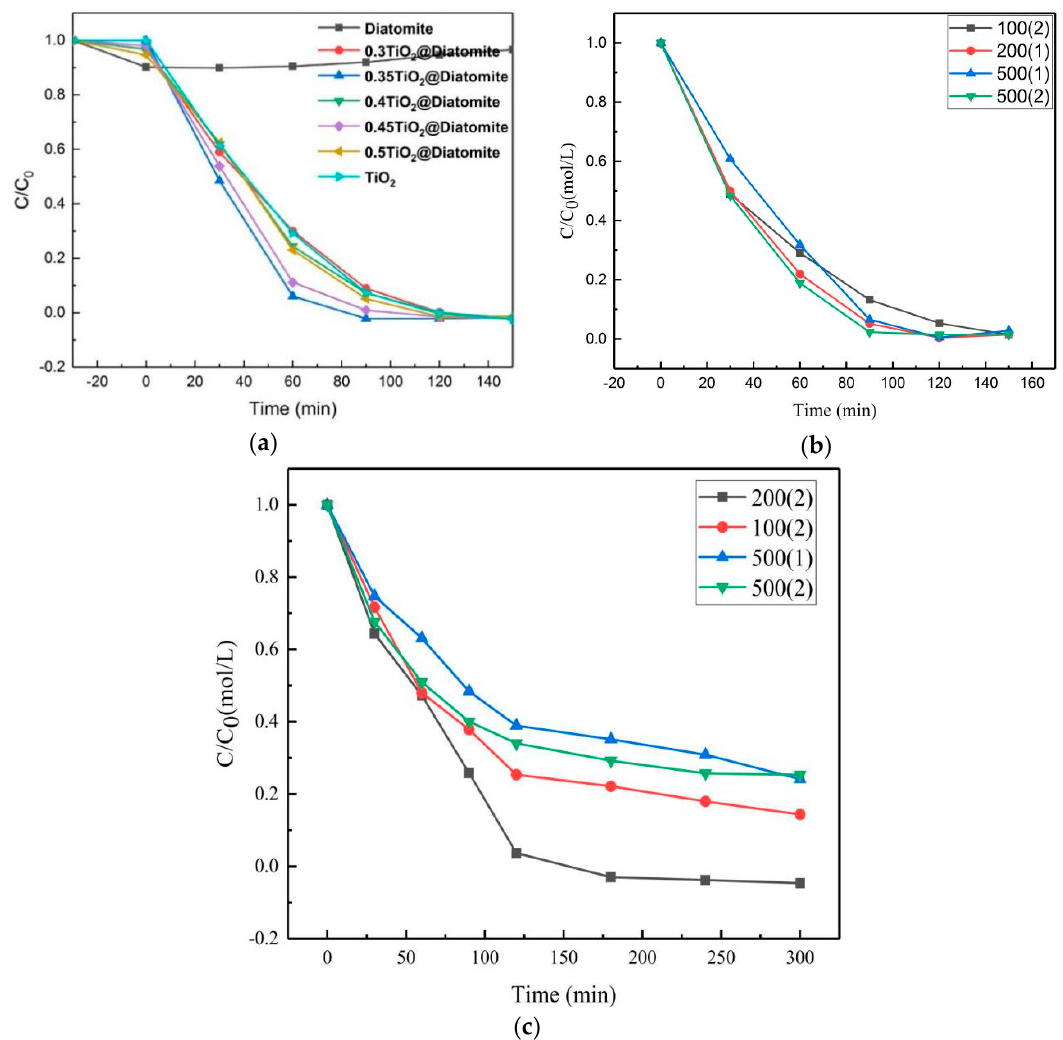
Figure 7. ( a ) Plots of the methylene blue (MB) photodegradation over various catalysts under UV irradiation. ( b ) Plots of the photodegradation of various concentrations of gaseous acetone over 0.35TiO 2 @diatomite under UV-Vis light irradiation. ( c ) Plots of the photodegradation of benzene at various concentrations over 0.35TiO 2 @diatomite under UV-Vis light irradiation.